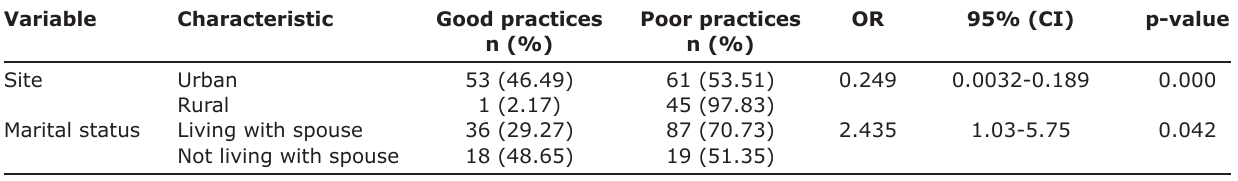
Table-5: Multivariate unconditional logistic regression analysis of factors associated with practices that expose to Brucella infection among high-risk persons in Lafia, Nasarawa State